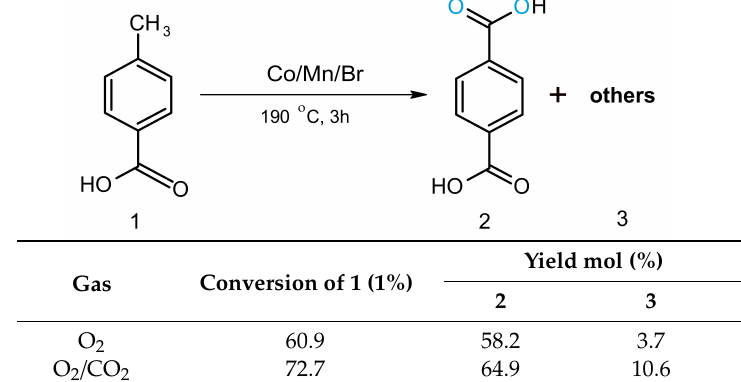
Table 5. p -toluic acid oxidation with CO 2 on an MC-type catalyst (Reproduced from [22]; copyright (2012), Royal Society of Chemistry).